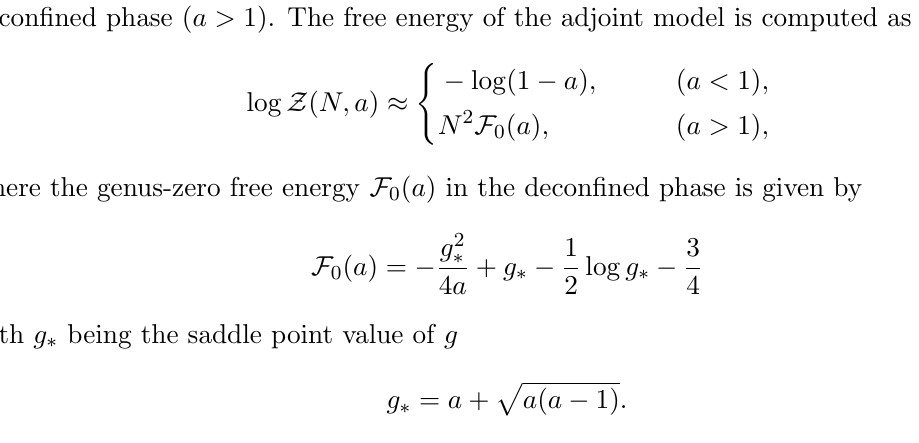
Figure 14. Plot of free energy log Z ( N; a ) for N = 30 in the range 1 = 2 < a < 2. In (a), we show the plot in the whole region 1 = 2 < a < 2, while in (b) and (c) we magnify the region a < 1 and a > 1, respectively. The red dots are the numerical value of the free energy. The solid curves in (b) and (c) represent (cid:0) log(1 (cid:0) a ) and N 2 F 0 ( a ) in (7.6), respectively. is dominated by Z ( N; a ) in the con(cid:12)ned phase ( a < 1) and by Z th-AdS